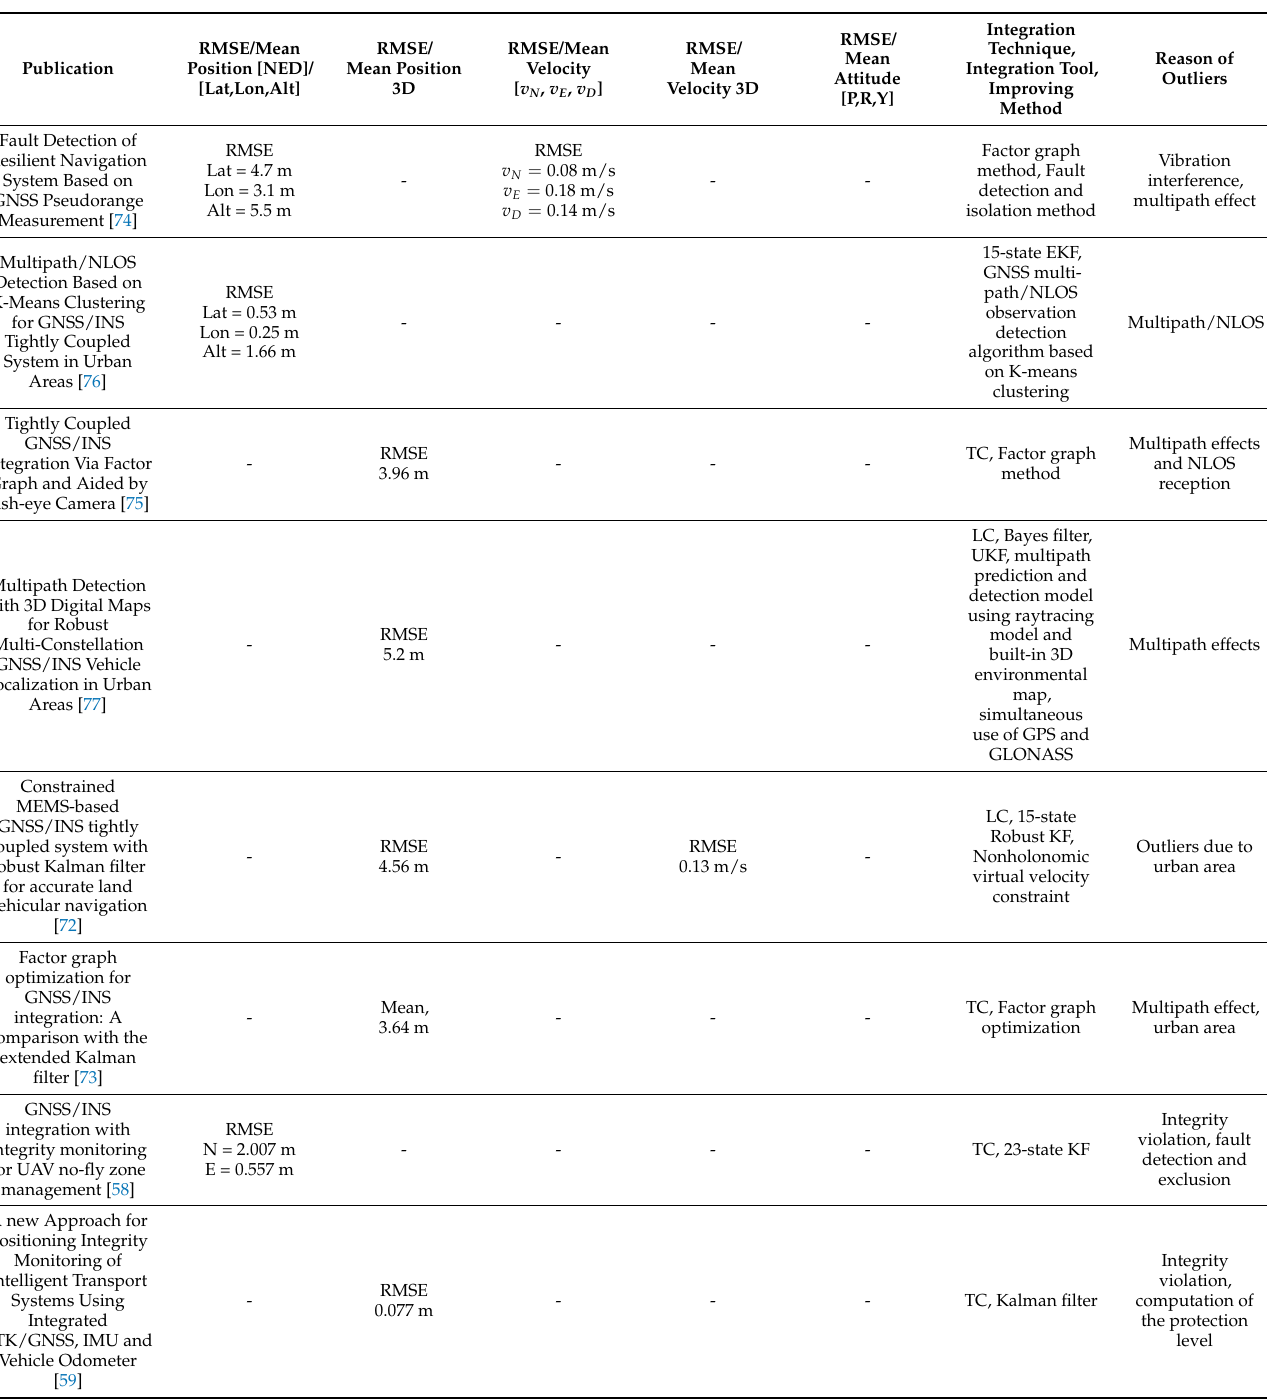
Table 5 provides a comparative description of various approaches to the implemen- tation of integrated INS/GNSS systems in the presence of errors and effects due to the characteristics of the sensors: INS drift, INS sensor alignment error with respect to the GNSS receiver and resulting lever arm effect, etc. Reducing of INS sensor errors is necessary to a large extent since the integrated system actually operates as an INS system when the GNSS signals are unavailable or